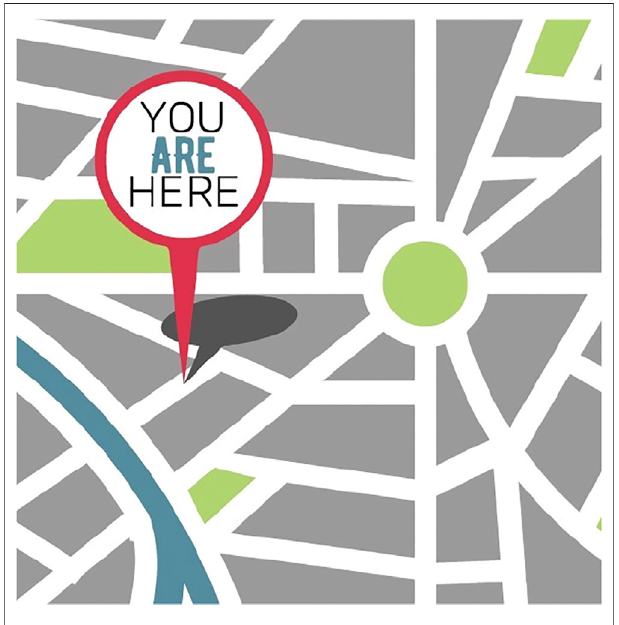
FIGURE 9 | An example of a You are here sign.